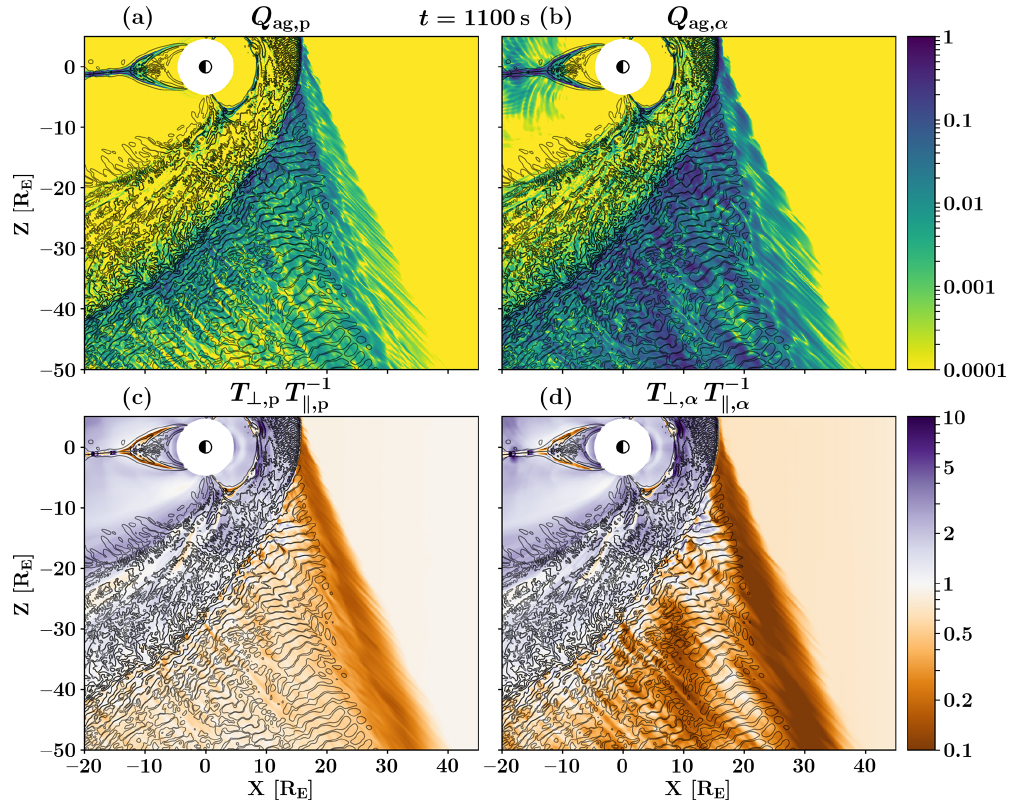
Figure 8. Foreshock characteristics for proton and helium at 1100s. (a, c) Protons and (b, d) helium are shown. (a, b) Agyrotropy Q ag (see Eq. 1), where a value of 0 corresponds with perfect gyrotropy. (c, d) Temperature anisotropy T ⊥ T − 1 (cid:107) calculated for the total distribution function, including both solar wind and suprathermal parts. Black contours show the out-of-plane magnetic field B y fluctuations at a level of ± 0 . 2nT, indicating the extent of the ULF foreshock